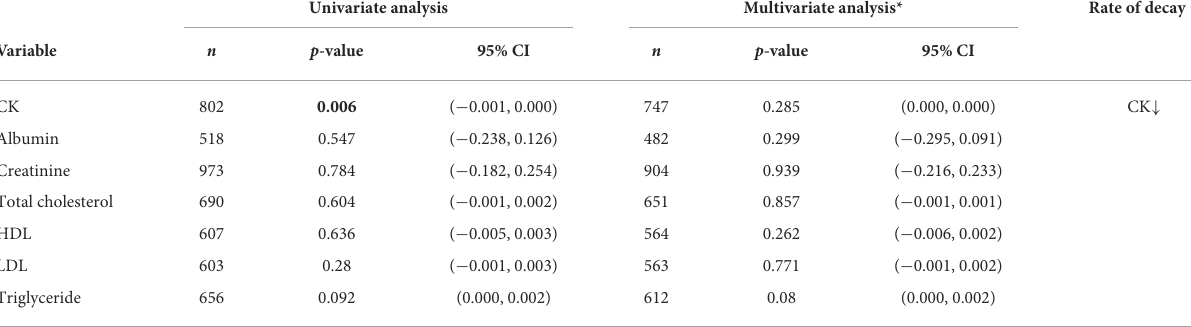
TABLE 3 Linear regression models for rate of decay and blood parameters. Univariateanalysis Multivariate analysis*